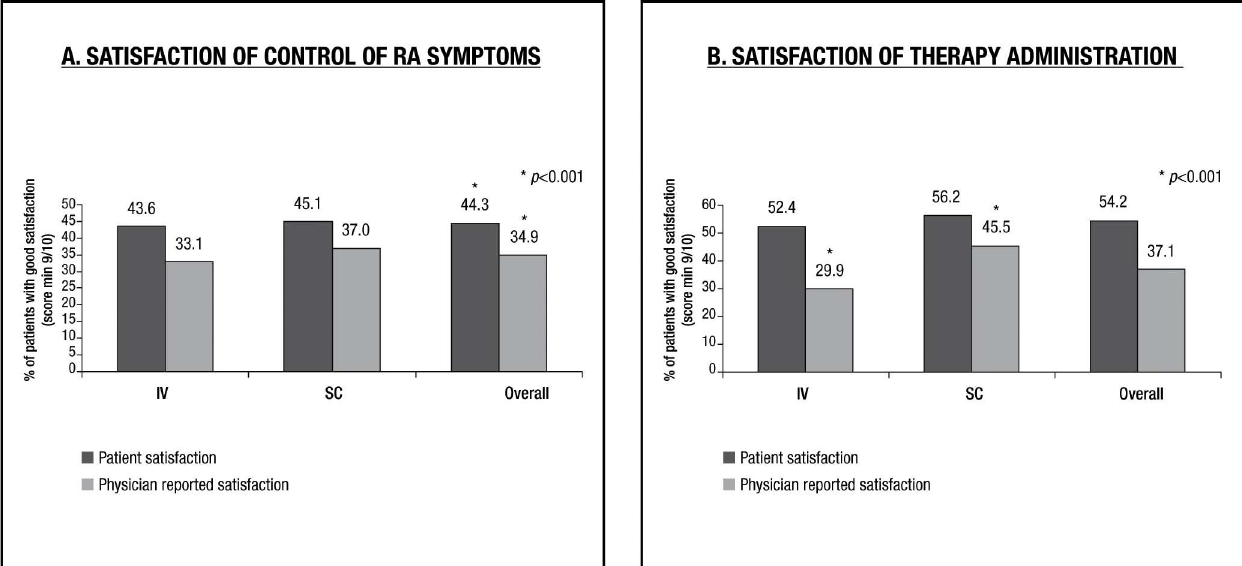
Fig 1. Patient satisfaction and associatedphysician’s opinion of control of RA symptoms and on therapy administration. IV: Intravenous; SC: